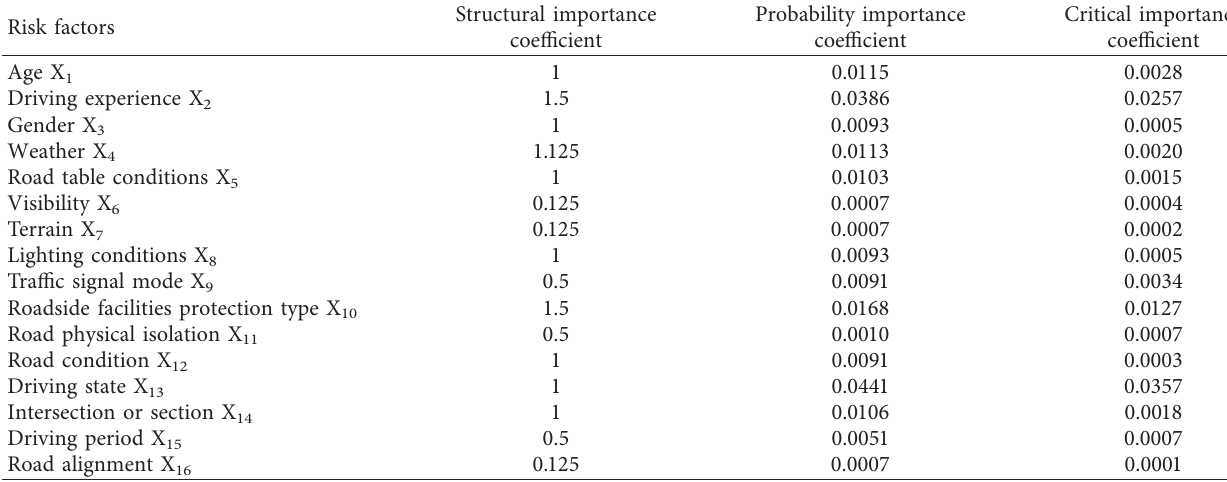
Table 1: Importance coefficient of risk factors of urban bus operation accidents.